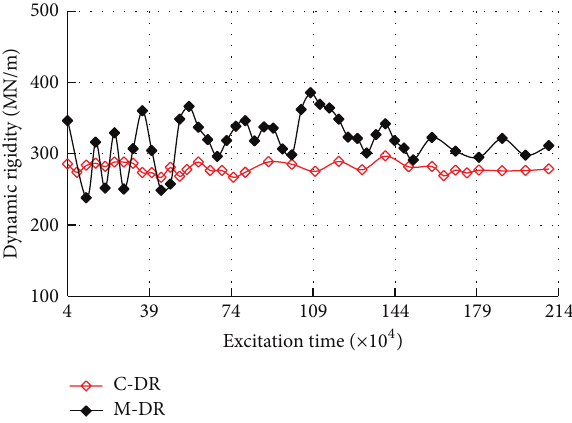
Figure 17: Dynamic soil pressure of subgrade along depth of subgrade.